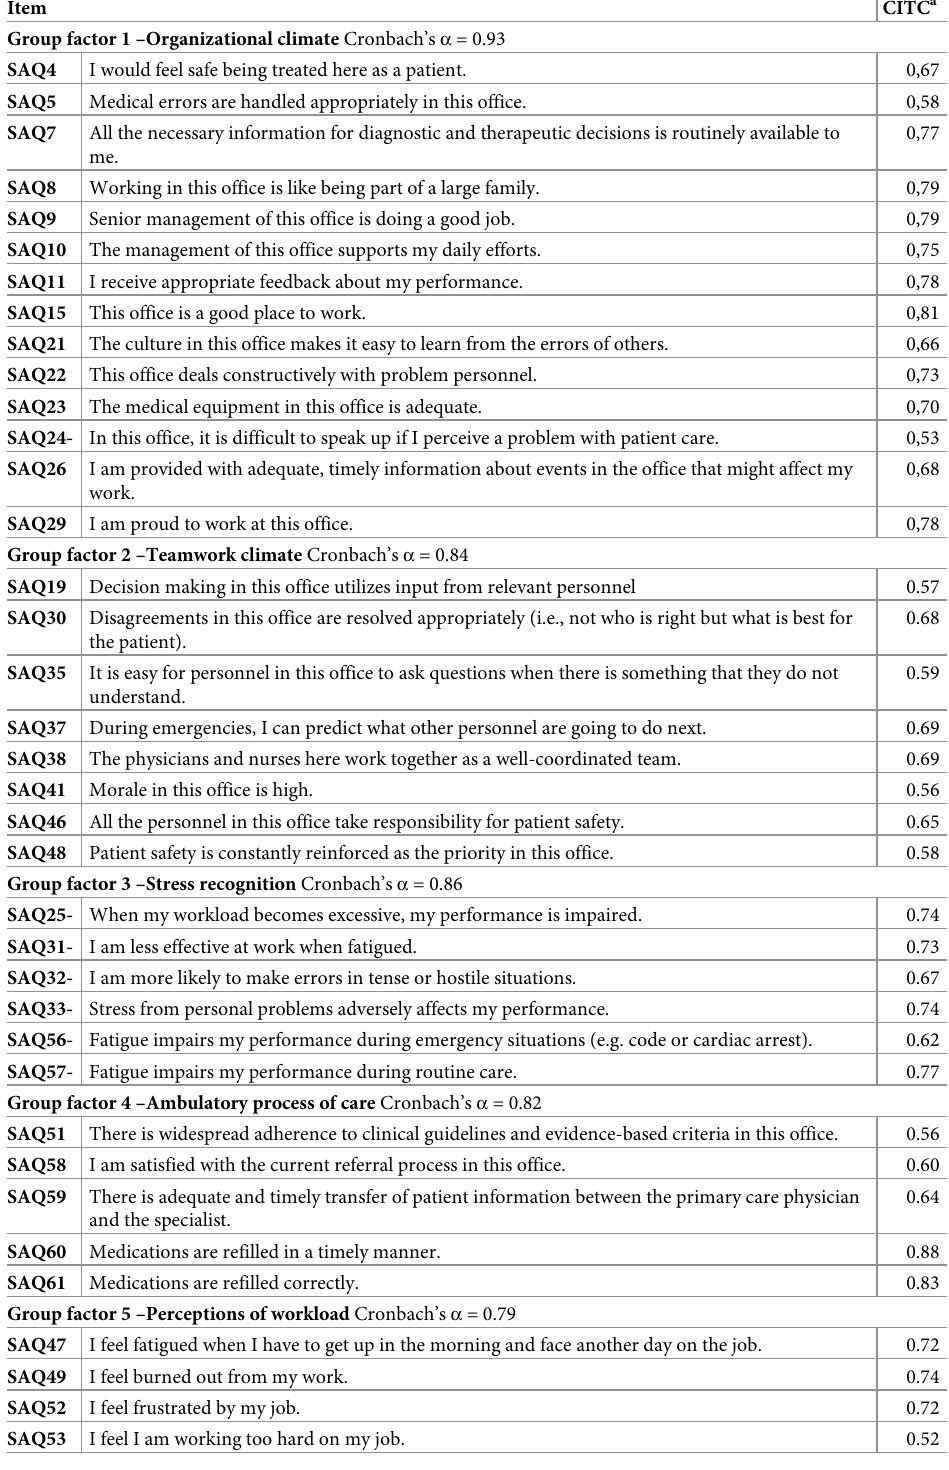
Table 4. Internal consistency of five group factors—Cronbach’s α and corrected item total correlations